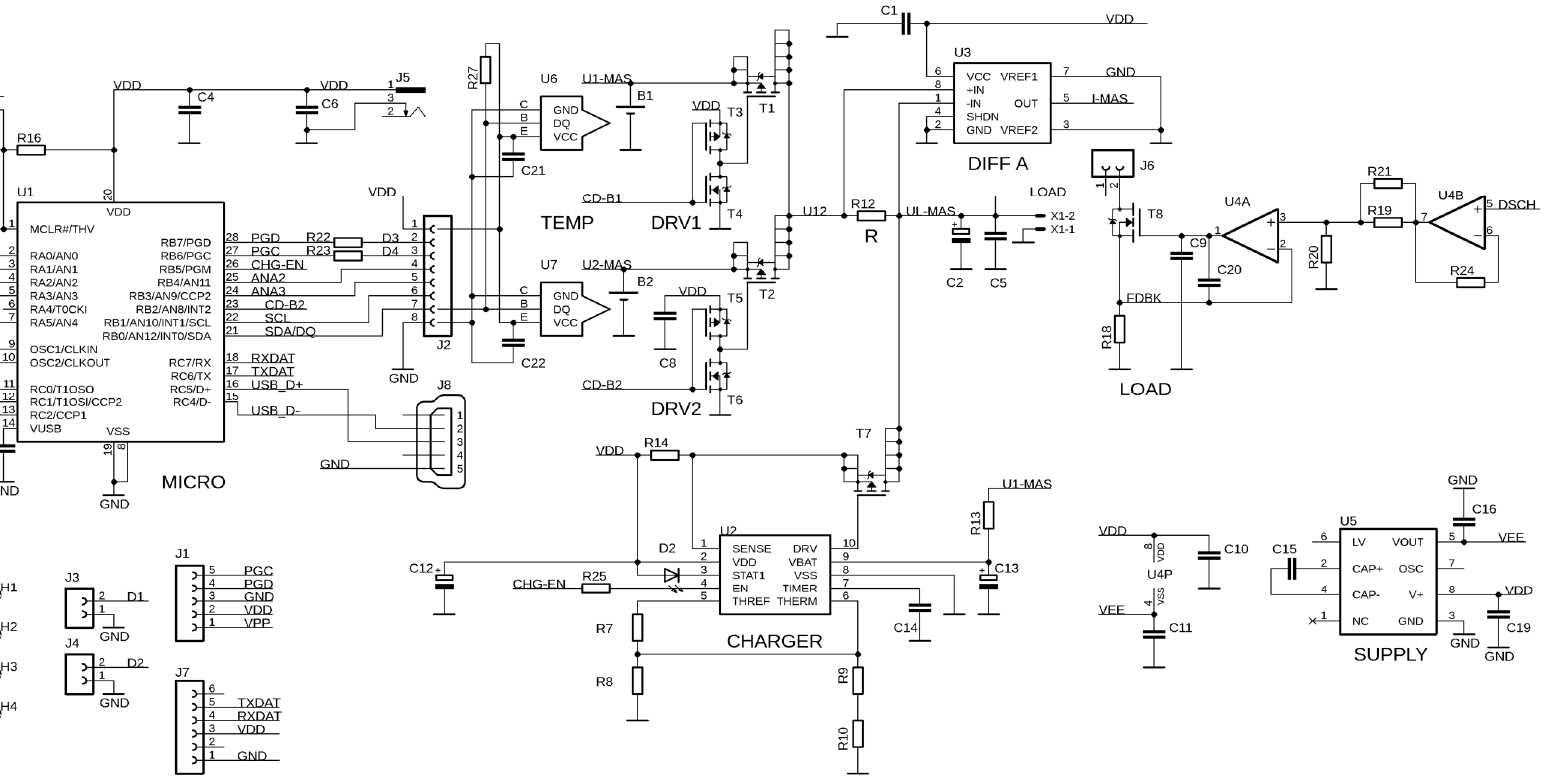
Figure A1. Detailed electronic schematic of SWD, the key elements: T1, T2, AP6681 U1 PIC18F25K50, U2 MCP73841, U3 TSC2012, U4 MCP6022, U5 ICL7660, U6,